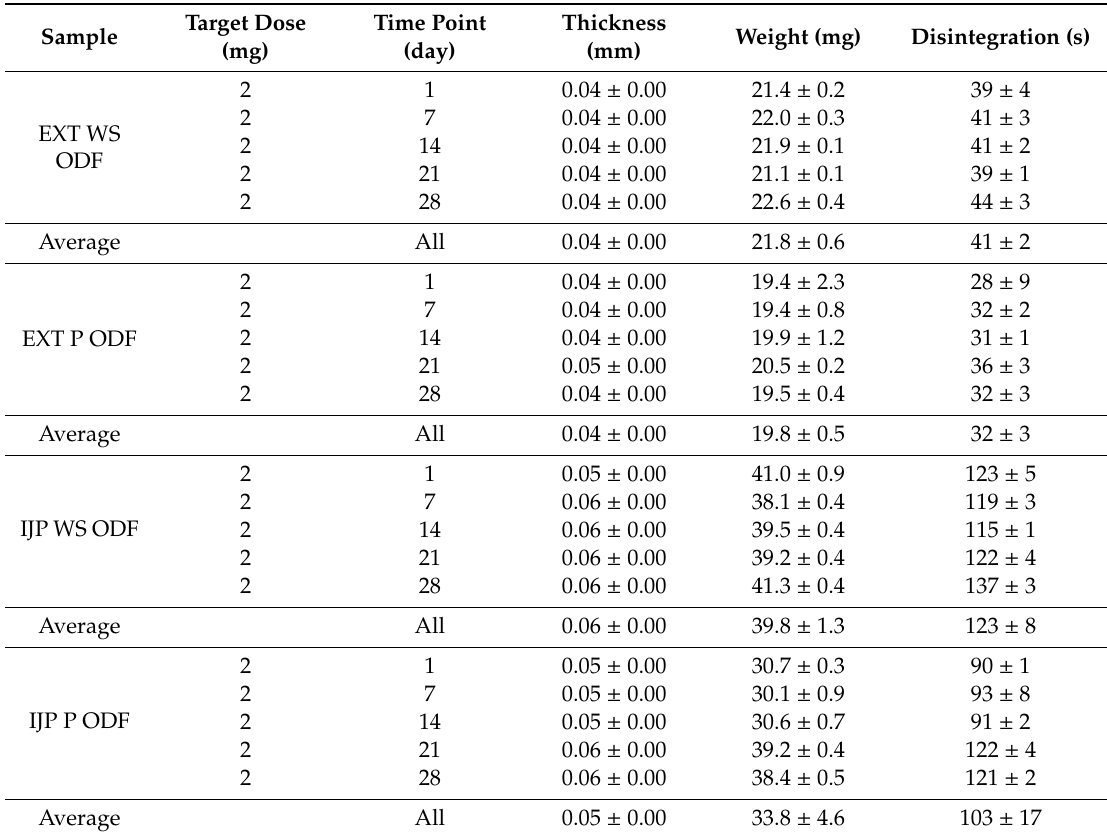
Table A4. Disintegration of the ODFs at di ff erent time-points during the stability study. Results presented as average ± SD, n = 3. WS = warfarin sodium, P = placebo.